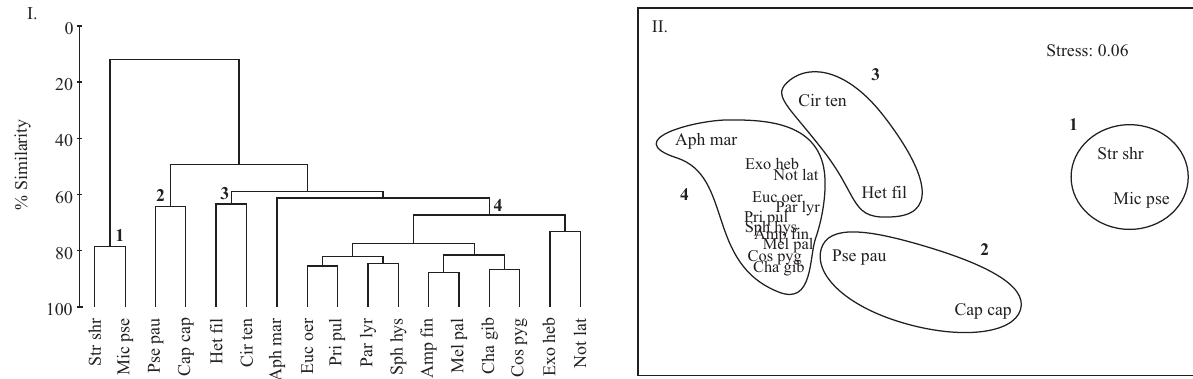
Fig . 3. – Dendrogram (i) and MDs (ii) using bray-Curtis similarity coefficient showing the classification and ordination of species with a numerical dominance ≥ 1%. species codes: amp fin, A. finmarchica ; aph mar, A. marioni ; Cap cap, C. cf. capitata ; Cha gib, C. gibber ; Cir ten, C. tentaculata ; Cos pyg, C. pygodactylata ; Euc oer, E. oerstedii ; Exo heb, E. hebes ; Het fil, H. filiformis ; Mel pal, M. palmata ; Mic pse, M. pseudoaberrans ; not lat, N. latericeus ; Par lyr, P. lyra ; Pri pul, P. pulchra ; Pse pau, P. paucibranchiata ; sph hys, S. hystrix ; str shr, S. shrubsolii . Table 3. – summary of characteristics for each association. - i. Eco- logical features of the polychaete assemblages determined in the En- senada de san simón, indicating average and standard deviation of biotic and physical characteristics. Q , median grain size; bt, 50